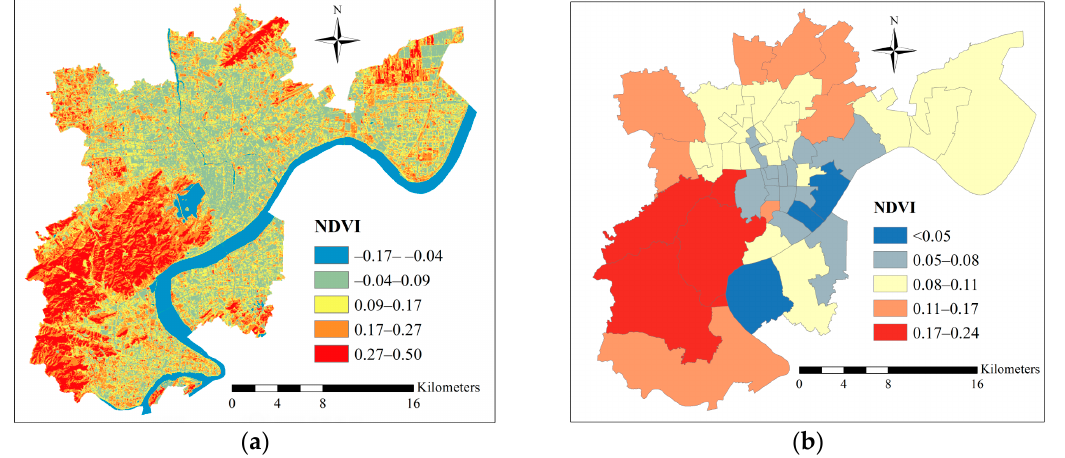
Figure 3. Normalized difference vegetation index (NDVI) retrieved from the Landsat 8 image: ( a ) inversion result with 30 m spatial resolution, and ( b ) average NDVI for street-town unit.